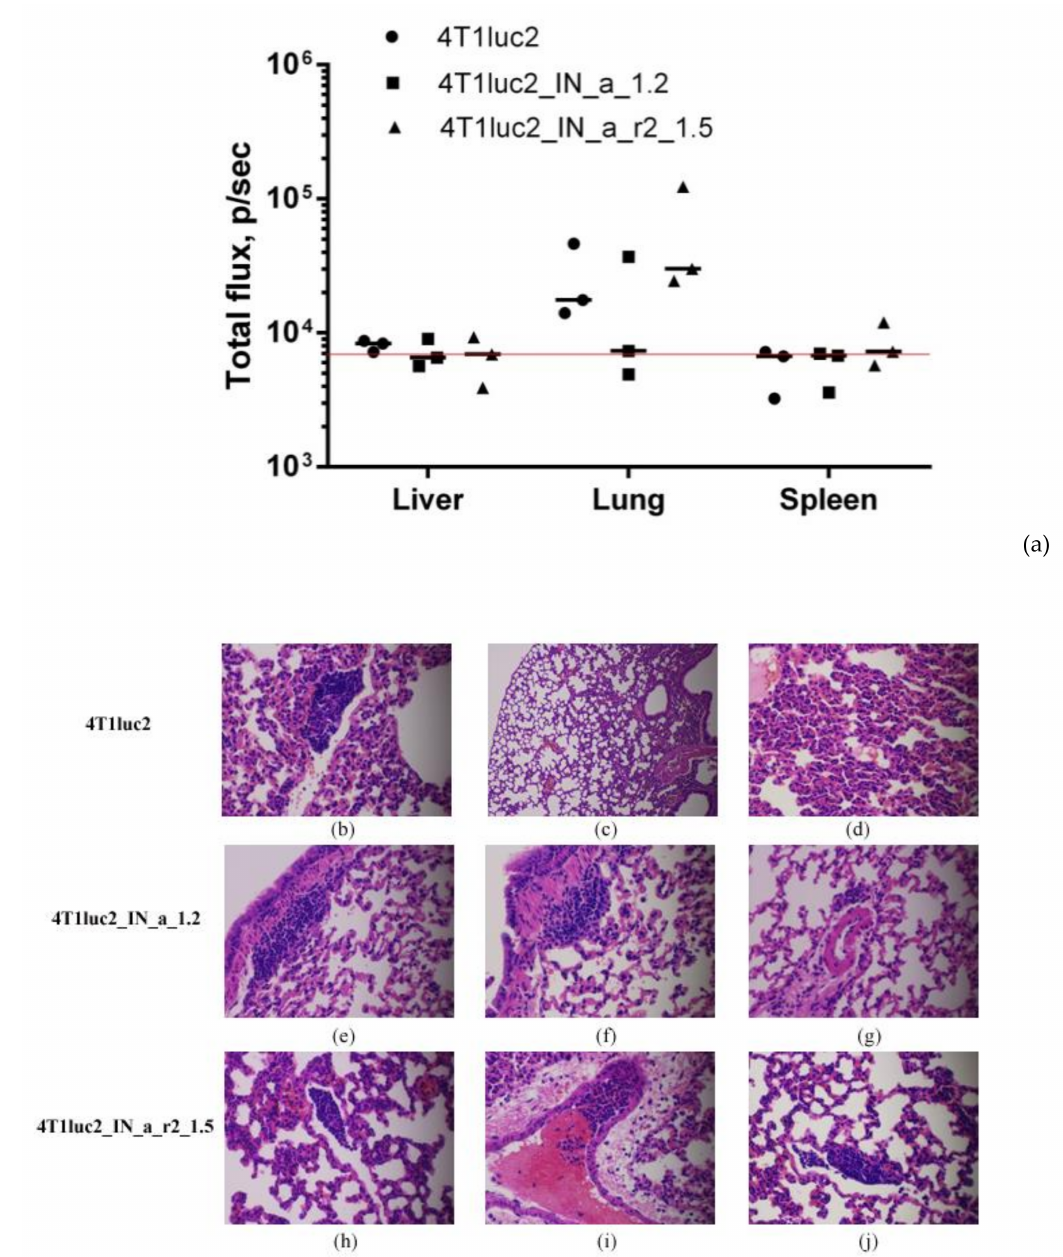
Figure 6. Murine adenocarcinoma 4T1luc2 cells expressing HIV-1 integrase have low metastatic activity. Infiltration of tumor cells into mouse organs ( a ) and histochemical characterization of lungs of mice implanted with the parental 4T1luc2 cells and their IN expressing derivatives ( b – j ) showing single metastases. Infiltration of Luc-expressing cells into organs was assessed by ex vivo BLI of the liver, lungs, and spleen; values represent a median of total flux from three organ samples ( p /sec); red line intercepts the background bioluminescence characteristic to one Luc-expressing 4Tl cell ( a ). H&E staining of FFPE sections of the lungs of mice implanted with 4T1luc2 ( b – d ), 4T1luc2_IN_a_1.2 ( e – g ), 4T1luc2_IN_a_r2_1.5 ( h – j ). Magnification × 100 ( c ), and × 400 elsewhere. Slides were examined and images were created using Leica DM500 microscope (Wetzlar, Germany) equipped with a digital camera. No significant difference was detected between organ infiltration in mice implanted with IN-expressing and parental 4T1luc2 cells ( p > 0.1, Kruskal–Wallis, Mann–Whitney